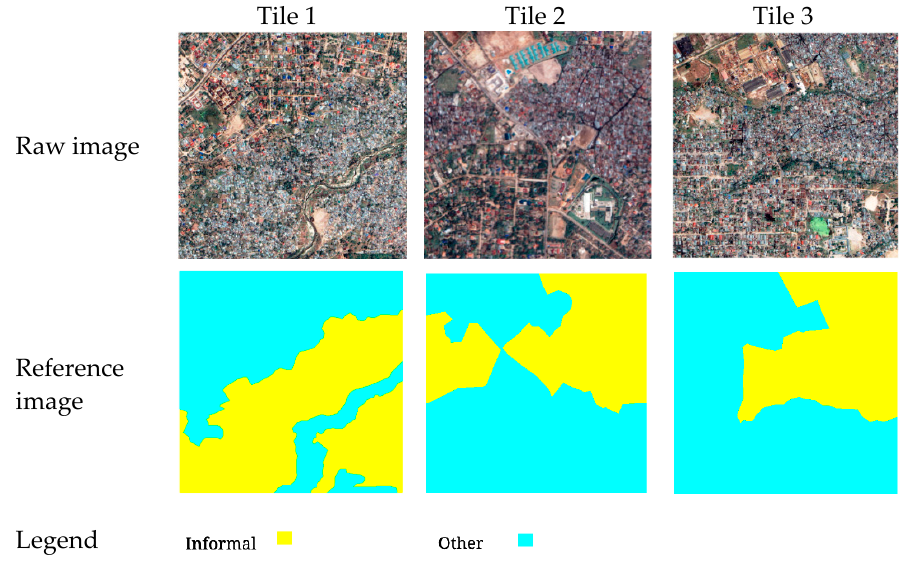
Figure 4. Raw QuickBird images of Dar es Salaam, Tanzania, and the corresponding reference data for Tile 1, Tile 2 and Tile 3 prepared by means of visual image interpretation. Each tile covers an area of 1.2 × 1.2 km on the ground.